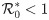
The epidemic behaviour as a function of FPSP duty-cycle and period.The total number of infected individuals plotted as a function of time for different FPSP policies. Colours distinguish duty-cycles. (Left) The success of the switching policy depends on whether or not the duty-cycle ensures R0*<1, in which case the epidemic dies out. Smaller duty-cycles outperform larger ones in terms of virus growth, but they lead to longer lockdowns. (Right) Epidemic evolution for different periods, from T = 2weeks to T = 4weeks. Across the panels, the dynamics are qualitatively the same, but they show that shorter periods perform better. For comparison, the time-behaviour corresponding to a full lockdown is also reported (FPSP [0, 7]).